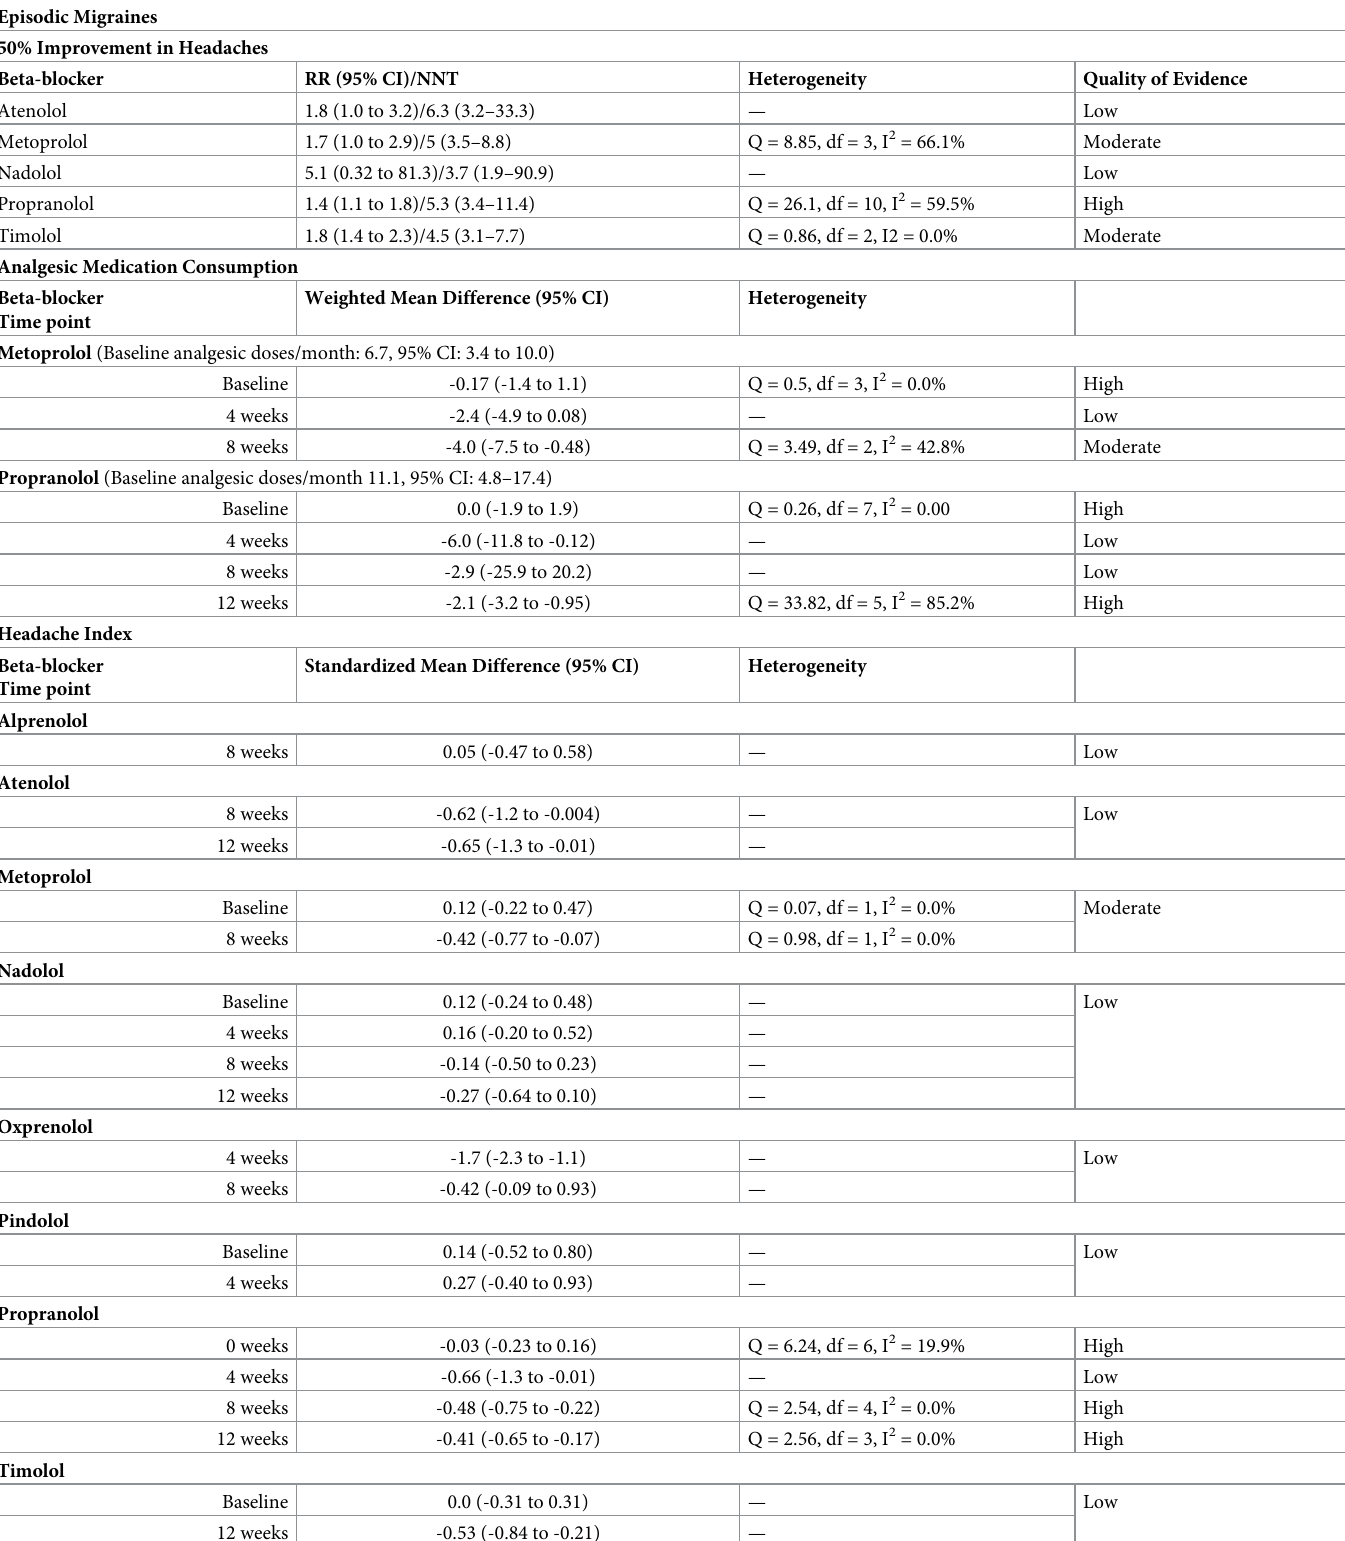
Table 3. Secondary outcomes of placebo controlled